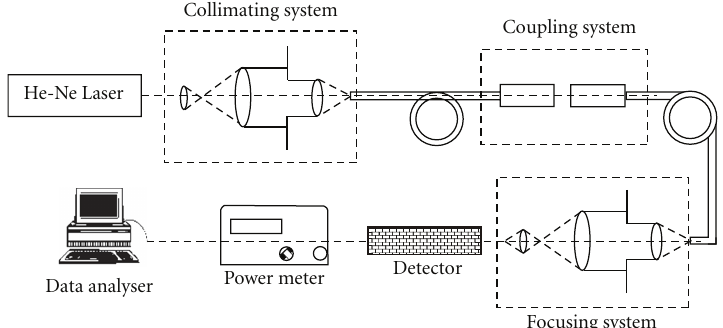
Figure 4: Experimental setup for the measurement of the power coupling e ffi ciency.